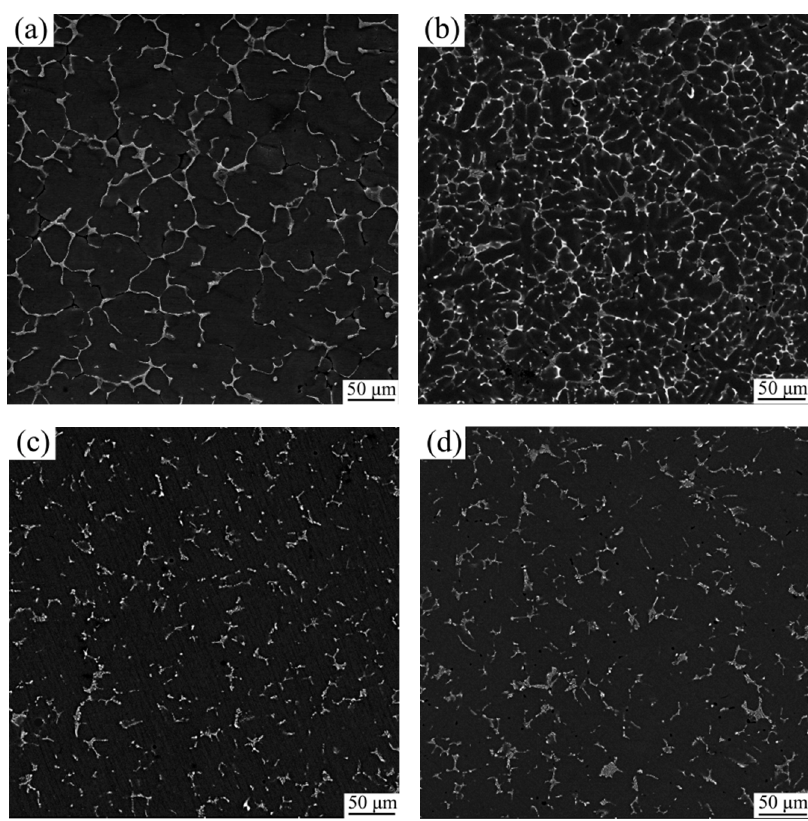
Figure 1. The microstructure of: ( a ) 7075 aluminum matrix as-cast; ( b ) Al 2 O 3np /7075 composites; ( c ) Al 2 O 3np /7075 composites under solution treatment at 480 °C for 5 h; ( d ) Al 2 O 3np /7075 composites under solution treatment at 480 °C for 5 h and aging treatment at 120 °C for 24 h.